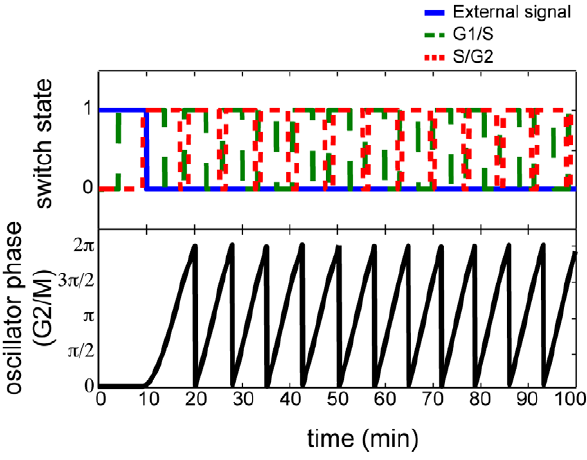
Figure 6. Simulated dynamics of an aberrant cell cycle network. As for Figure 5 with a network topology linking the G2/M module to the G1/S module.